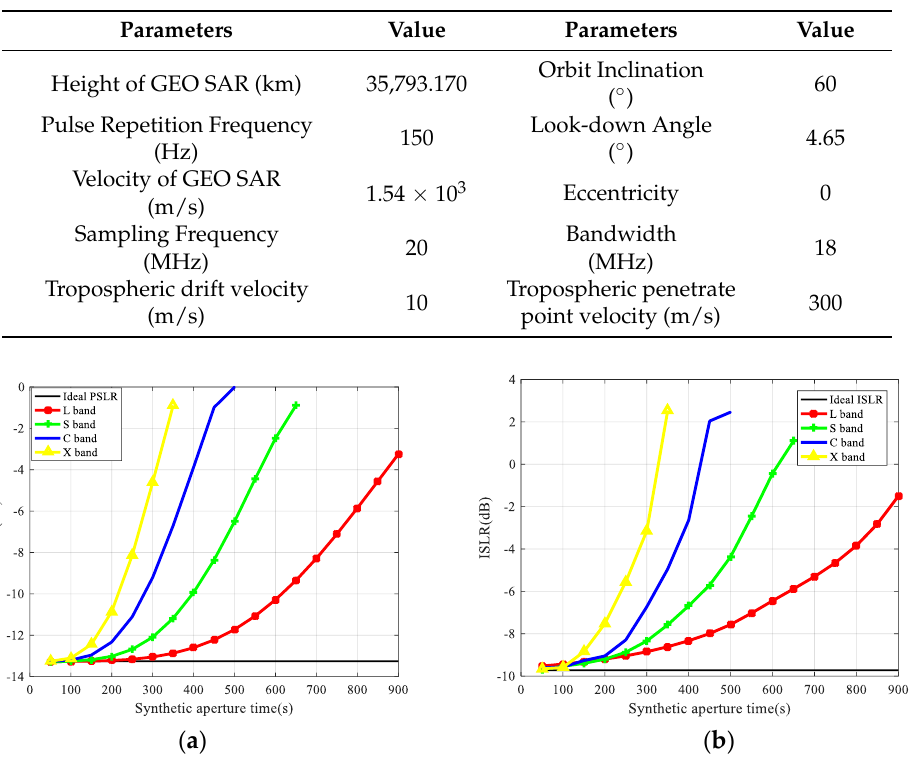
Table 2. System and orbit parameters of GEO SAR.